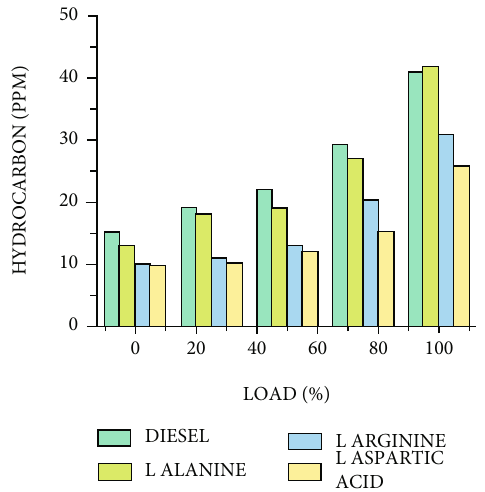
Figure 12: Variation of hydrocarbon with respect to engine load.